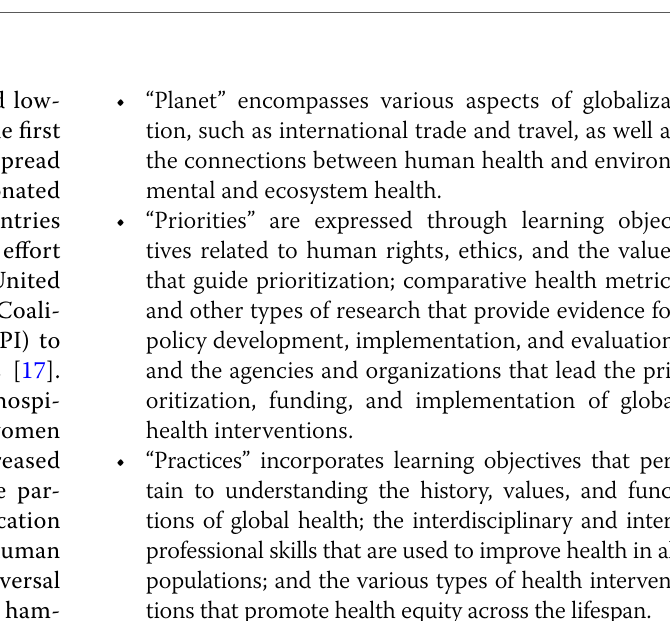
Fig. 1 The 5 Ps model of global health